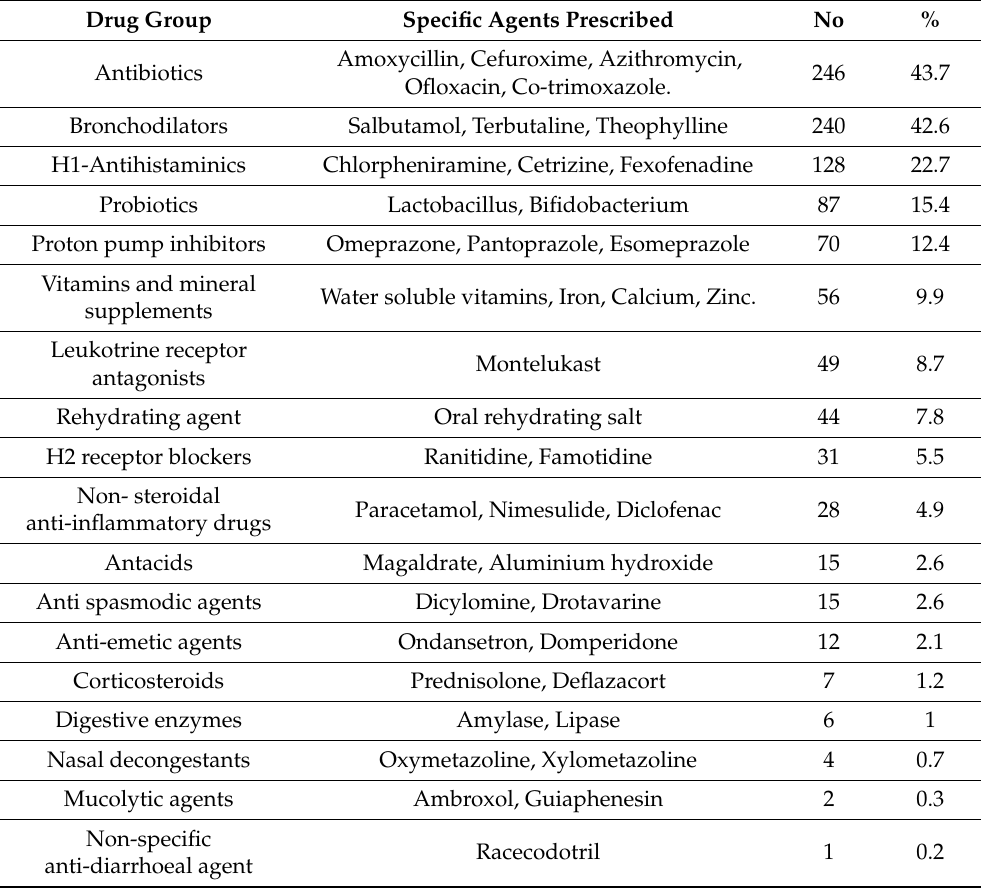
Table 3. Distribution of Drug responsible for unacceptable prescription. ( n = 563 prescriptions, proportions are not mutually exclusive).